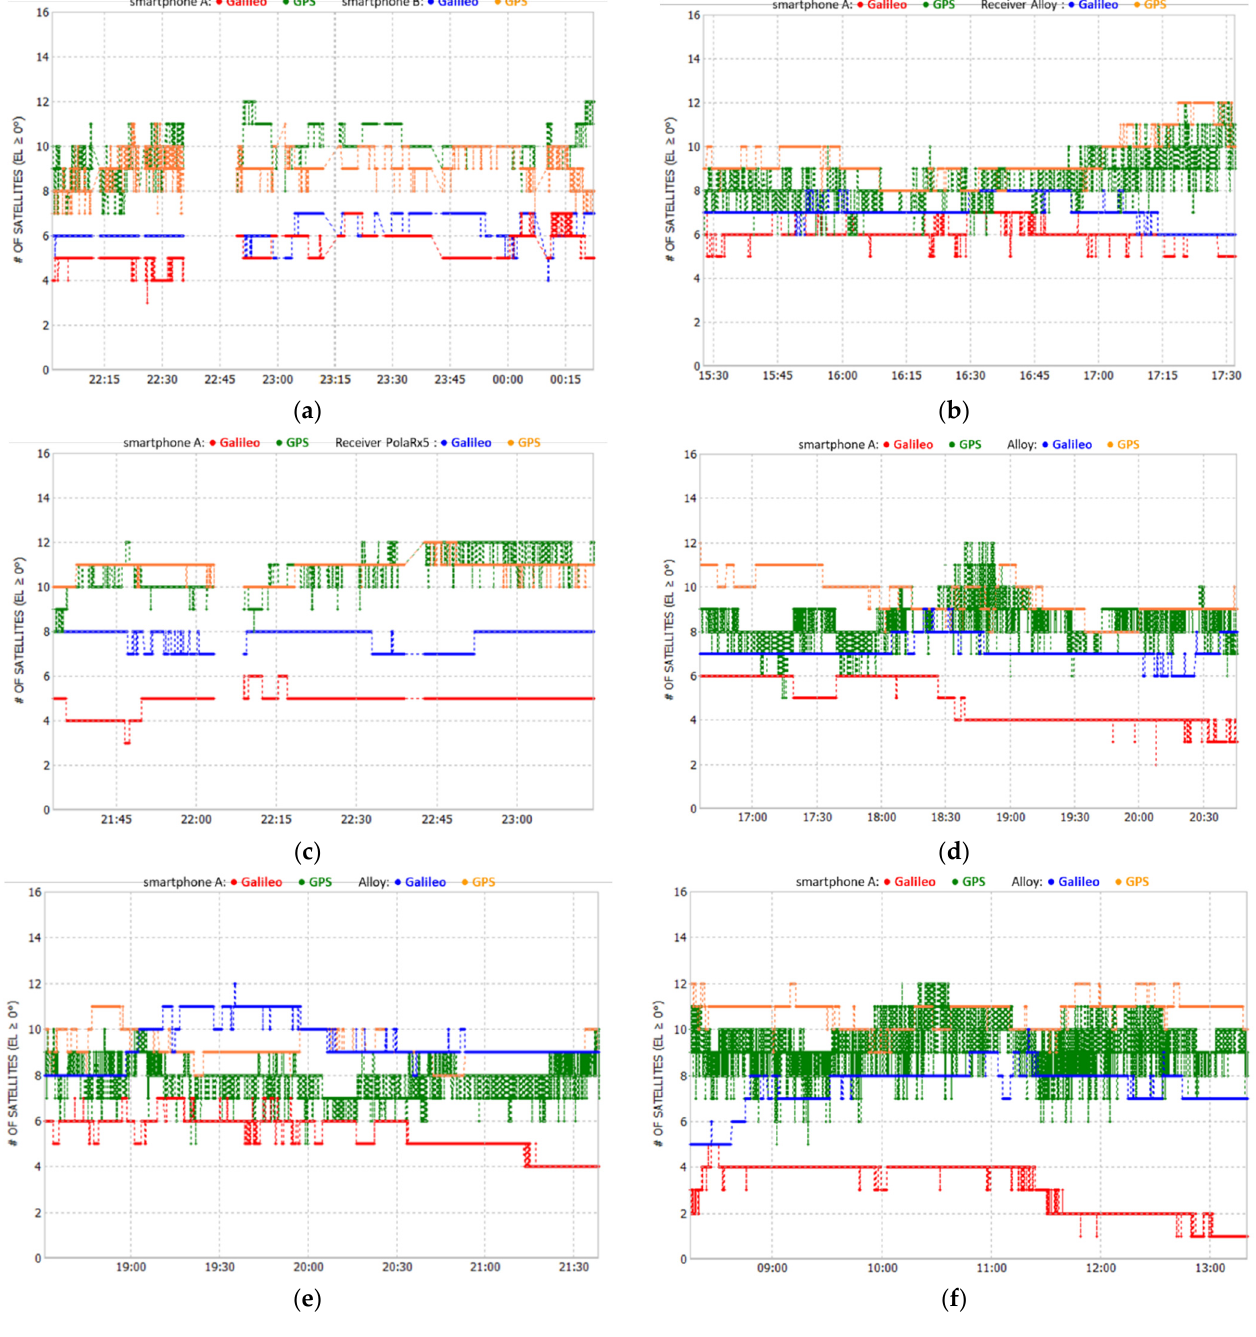
Figure 5. Number satellites for Galileo and GPS: Test 1 ( a ); Test 2 ( b ); Test 3 ( c ); Test 4 ( d ); Test 5 ( e ); Test 6 ( f ).